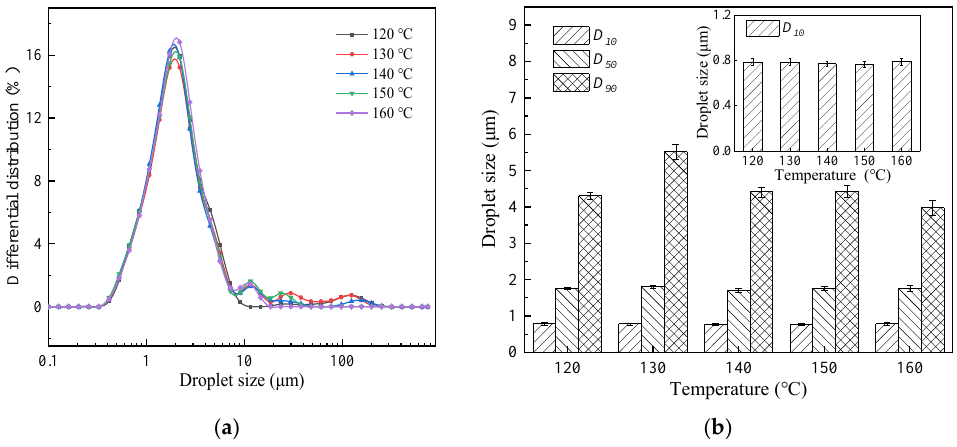
Figure 4. Droplet size distribution of asphalt emulsions fabricated at different shear time. ( a ) Droplet size distribution; ( b ) Representative droplet sizes.